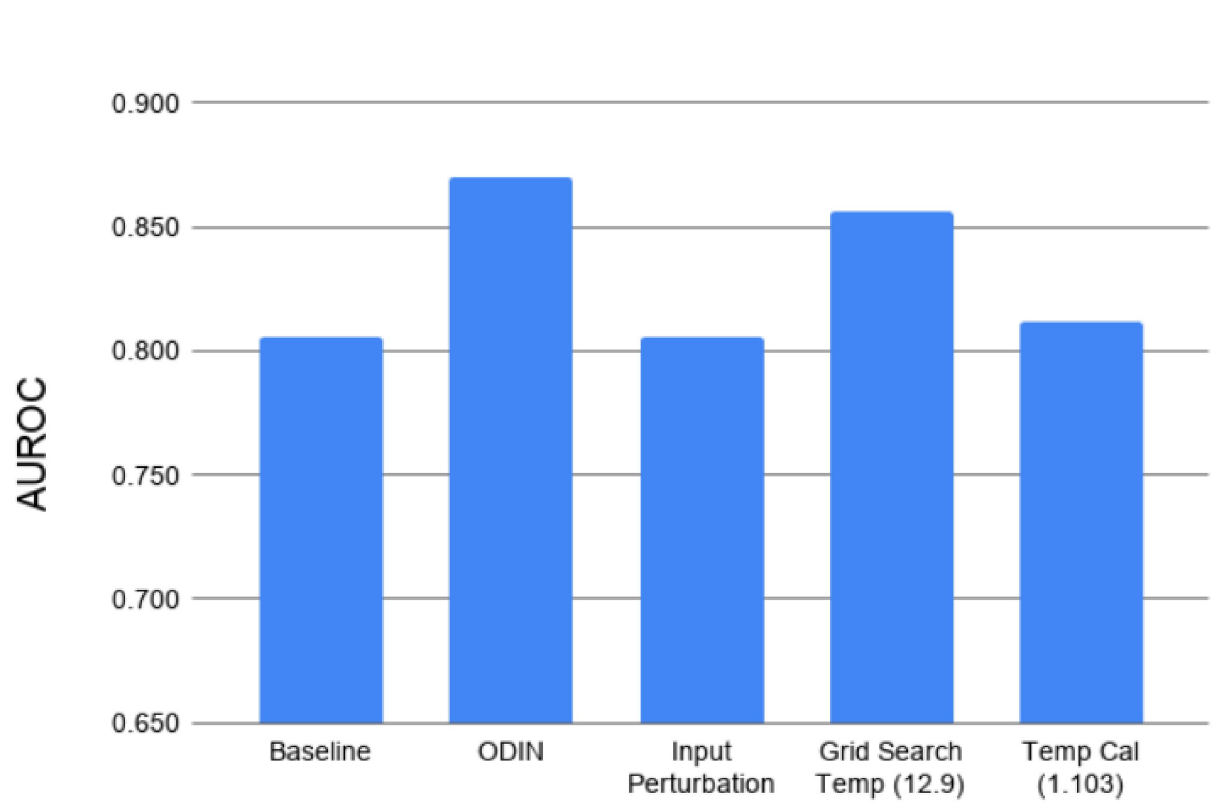
Fig 4. Effects of input perturbation and temperature scaling. An ablation experiment for detecting intra-dataset open set classes on a ResNet-18 model trained on 500 classes of ImageNet. As shown an optimal temperature scaling factor provides much of the overall performance benefit from the ODIN method with virtually no increase in computational